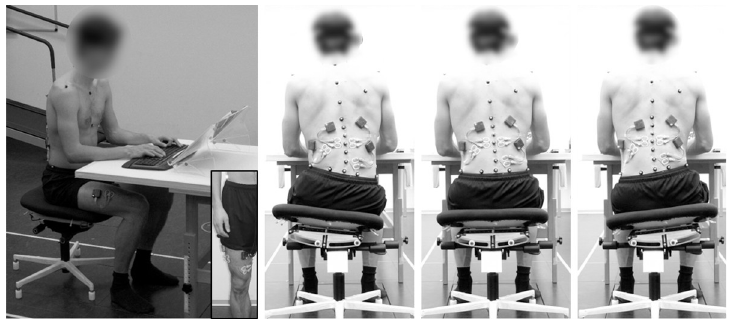
Fig 2. Measurement setting. Lateral and posterior views of a subject during active sitting, including electrode and marker placement. The three pictures on the right show examples of the central and the maximum left and right positions. Note that subjects placed their palms on the wrist rest of the